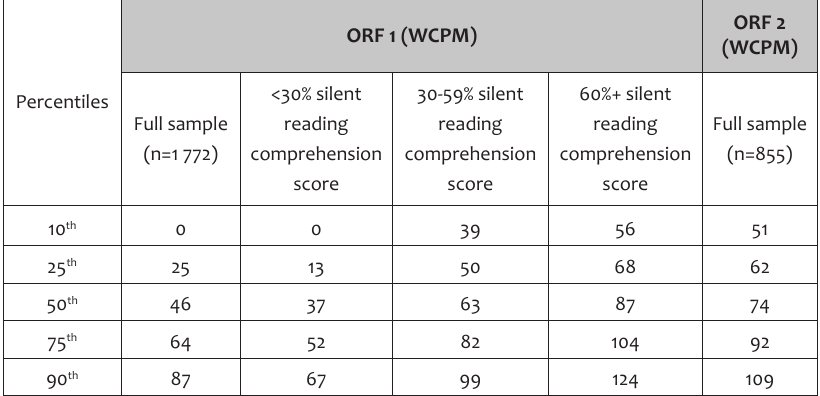
Figure 4: CDF of WCPM on ORF 1 per category of performance on the silent reading comprehension test Table 9: Percentile distributions of words correct per minute for ORF 1 (with sub- groups of comprehension achievement) and ORF